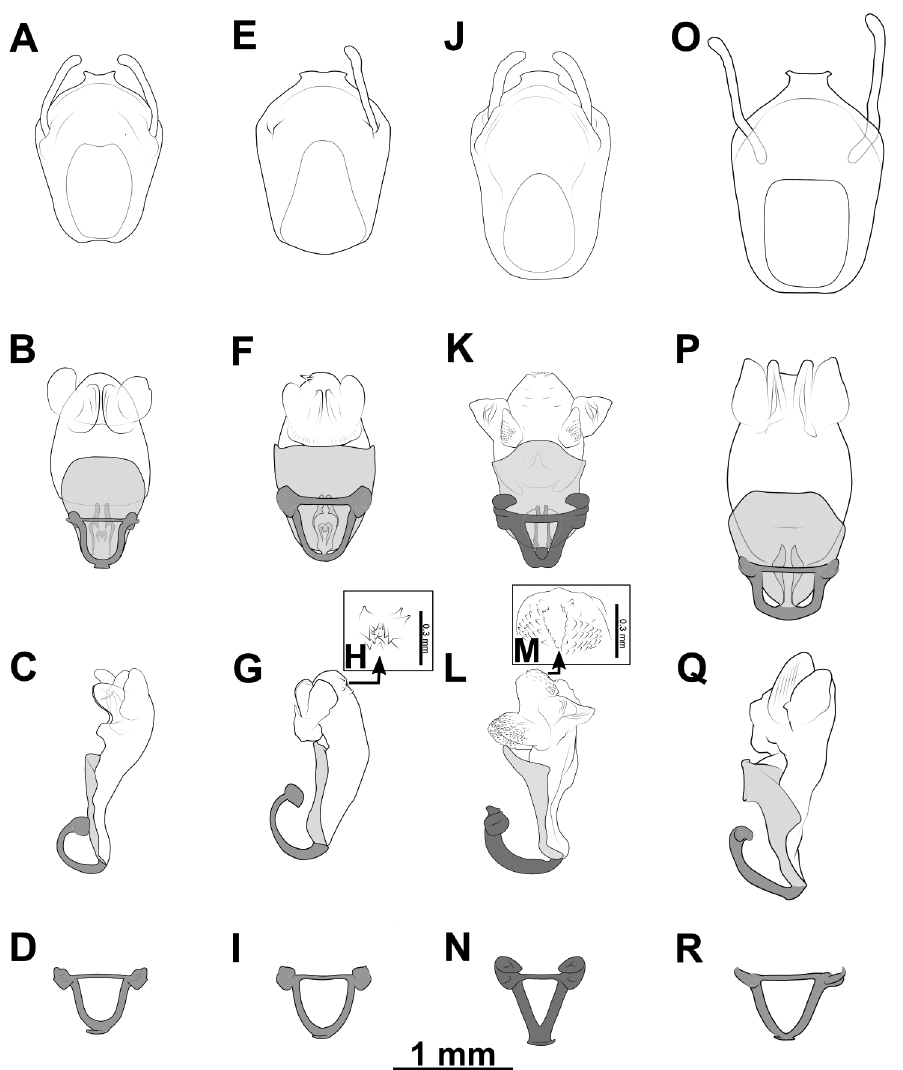
Figure 6. Male genitalia of four morphospecies A–D type mA, Biasticus taynguyenensis Ha, Truong & Ishikawa, sp. nov., paratype, ♂ , TXL2016-545 E–I type mB, B. griseocapillus Ha, Truong & Ishikawa, sp. nov., paratype, ♂ , TXL2016-546 J–N type mC, B. luteicollis Ha, Truong & Ishikawa, sp. nov., holotype, ♂ , HNL2018-025 O–R mF, B. flavus (Distant, 1903), ♂ , HEM-TH2004-018. A, E, J, O pygophore with paramere(s) in dorsal view B, F, K, P phallus in dorsal view C, G, L, Q phallus in lateral view D, I, N, R articulatory apparatus H, M distal dorsal lobe of